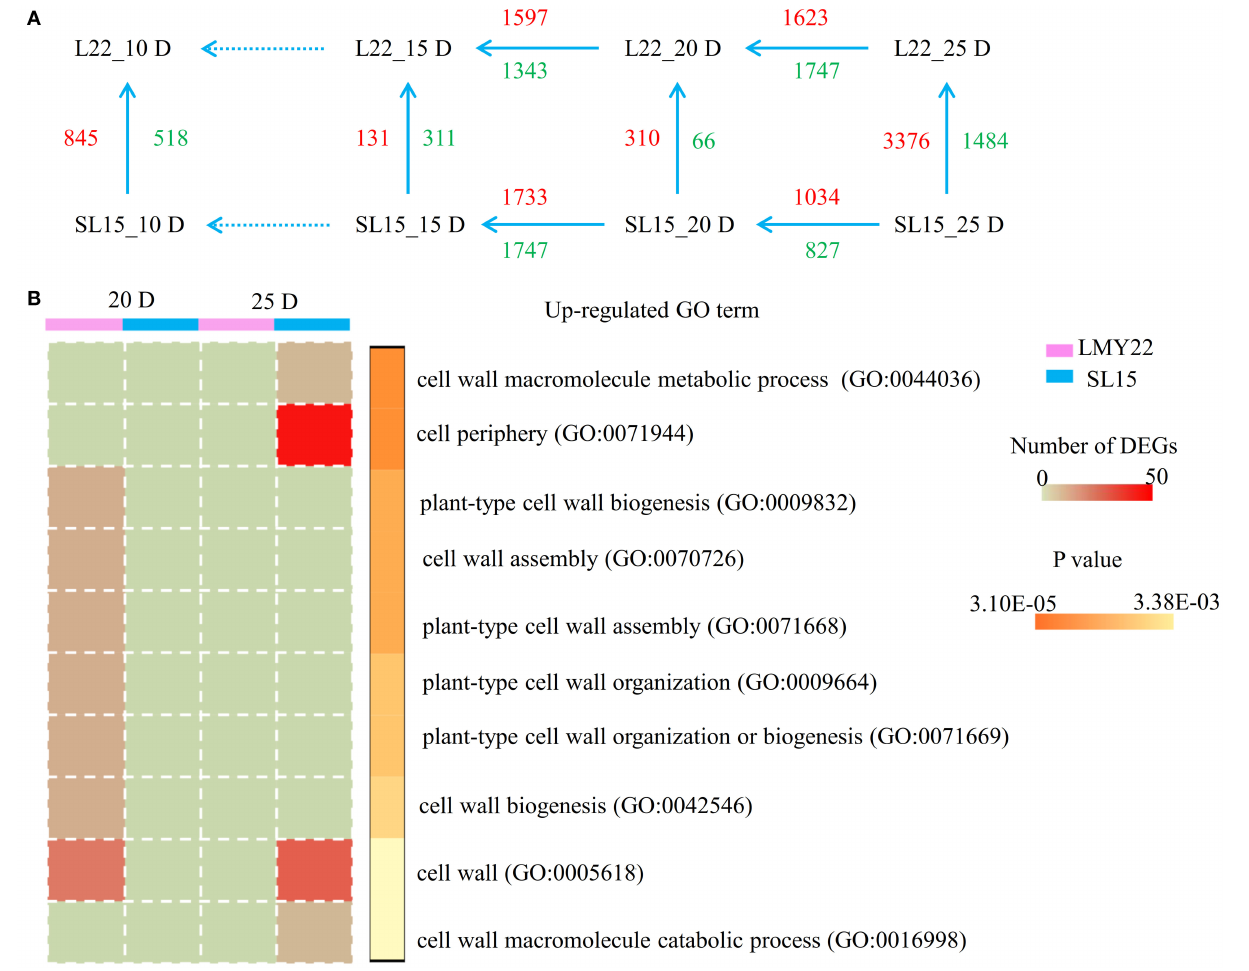
FIGURE 3 | Global transcriptome analysis. (A) Numbers of DEGs within and between LMY22 and SL15. (B) GO analysis comparing 20 DPA and 25 DPA in LMY22 and